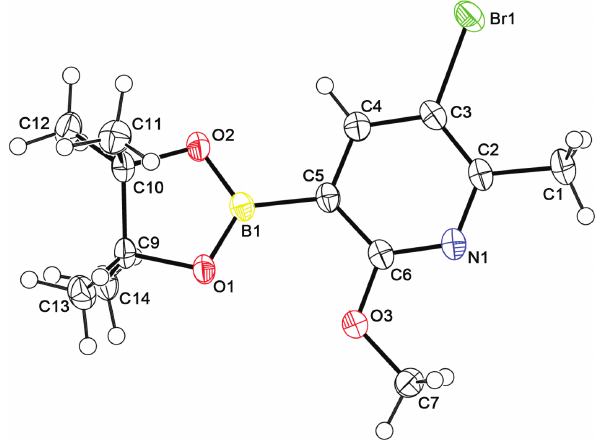
Table 1: Data collection and handling.